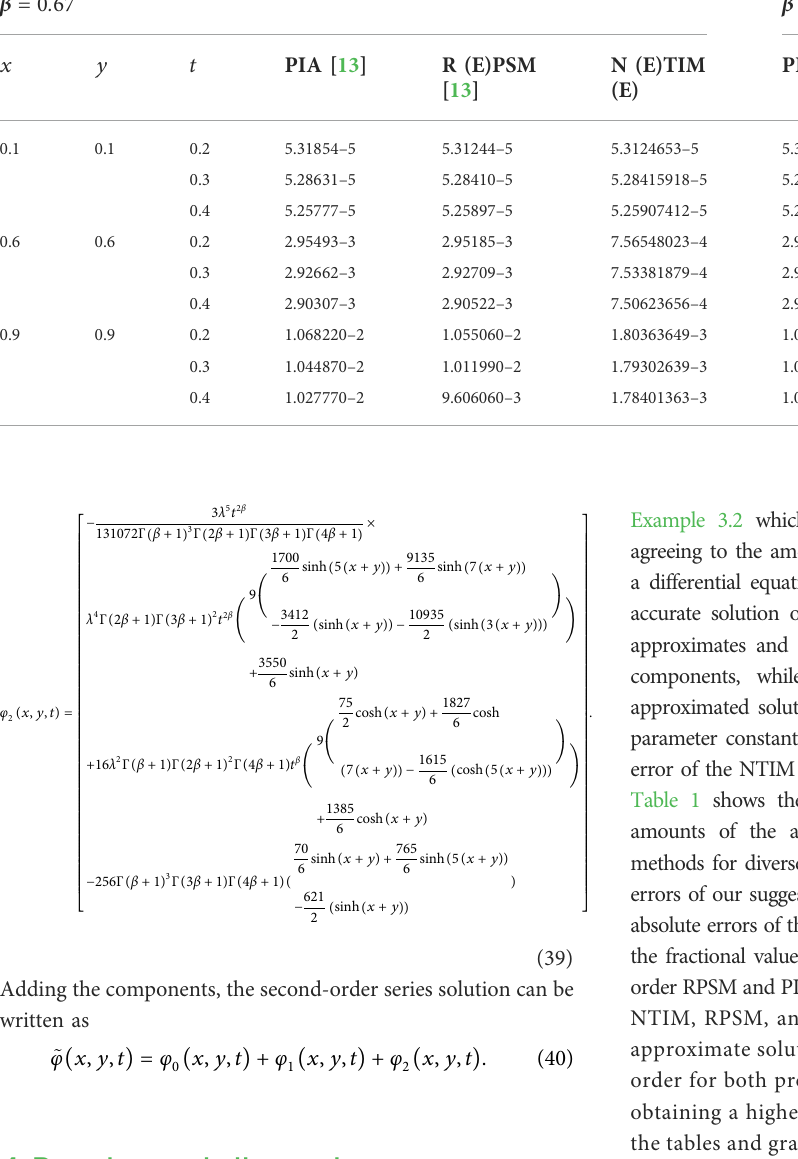
TABLE 2 Comparison of the second-order NTIM with the third-order RPSM and PIA method for diverse amounts of β . β (cid:2) 0 .